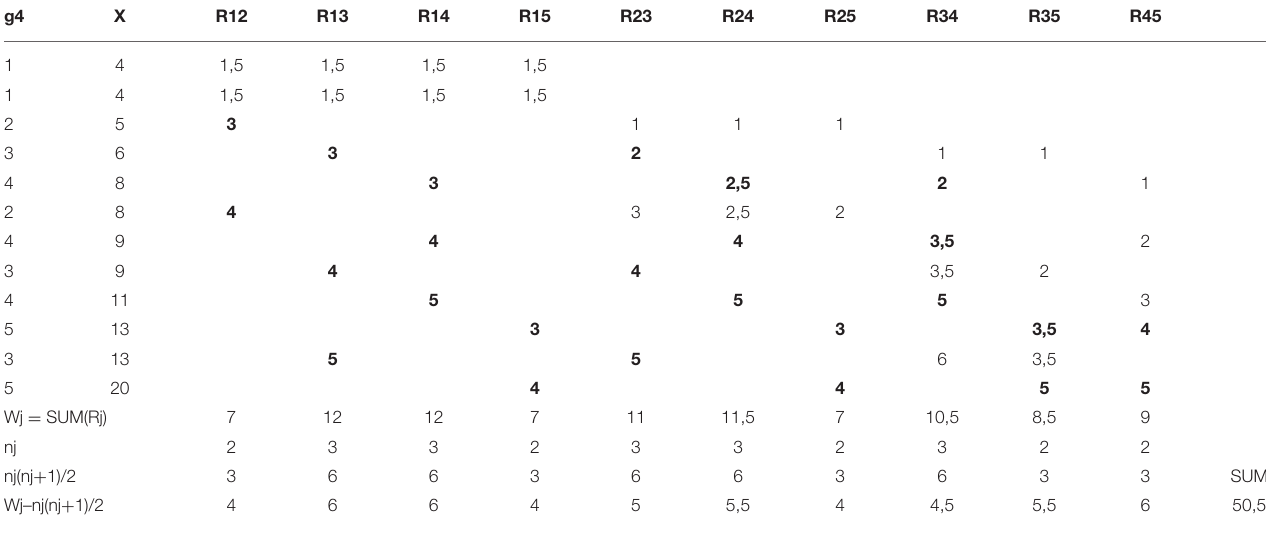
TABLE 3 | Rank-orders (R) in different pairs of i, j between variables g4 and X; the ranks of the higher sub-population j are